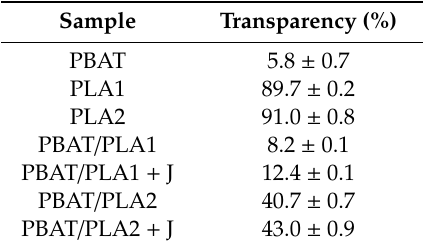
Table 3. Transparency of the films.